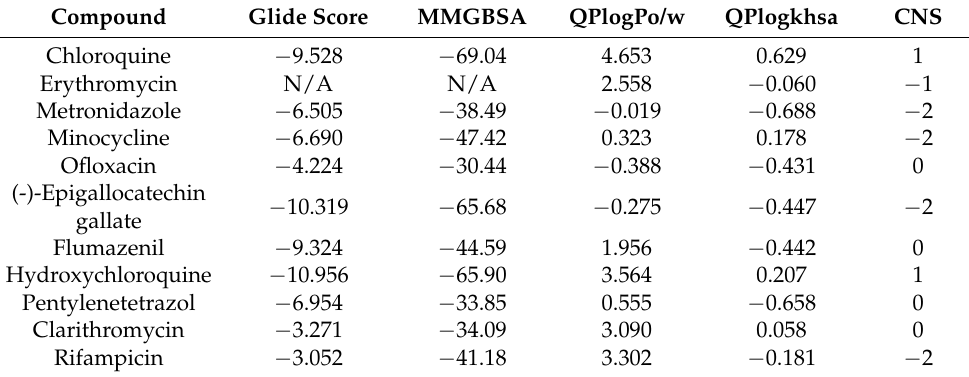
Table 2. In silico modeling parameters for docking 11 compounds to the 6DW0.pdb GABA A recep- tor